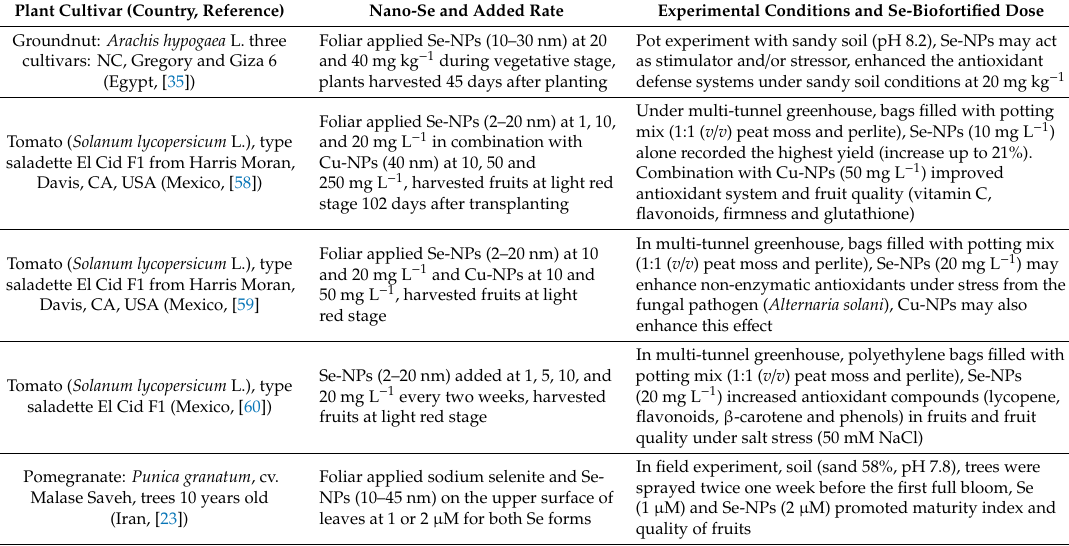
Table 4. The role of selenium-nanoparticles (Se-NPs) in the growth of selected plants under di ff erent growth